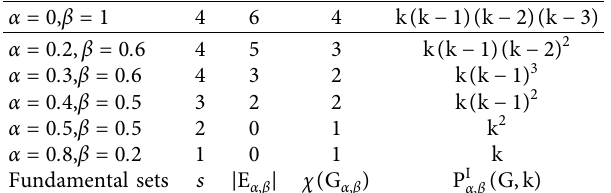
Table 1: The comparison of | V IFG in Figure